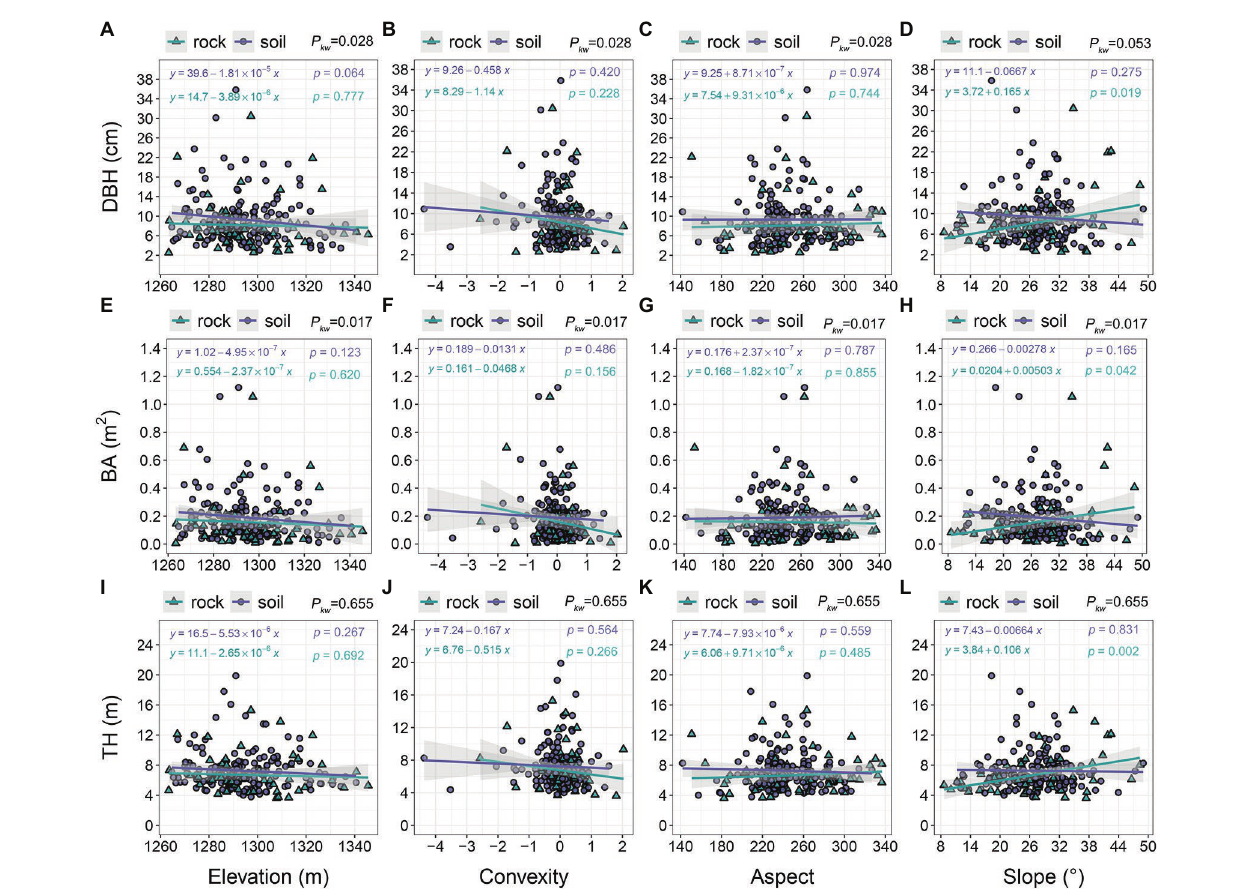
FIGURE 7 | The relationships of tree size with topographic variables. p kw > 0.05, 0.01 < p kw < 0.05, and p kw < 0.01 represent non-significant, significant, and highly significant differences, respectively. DBH = diameter at breast height, BA = basal area, and TH = tree